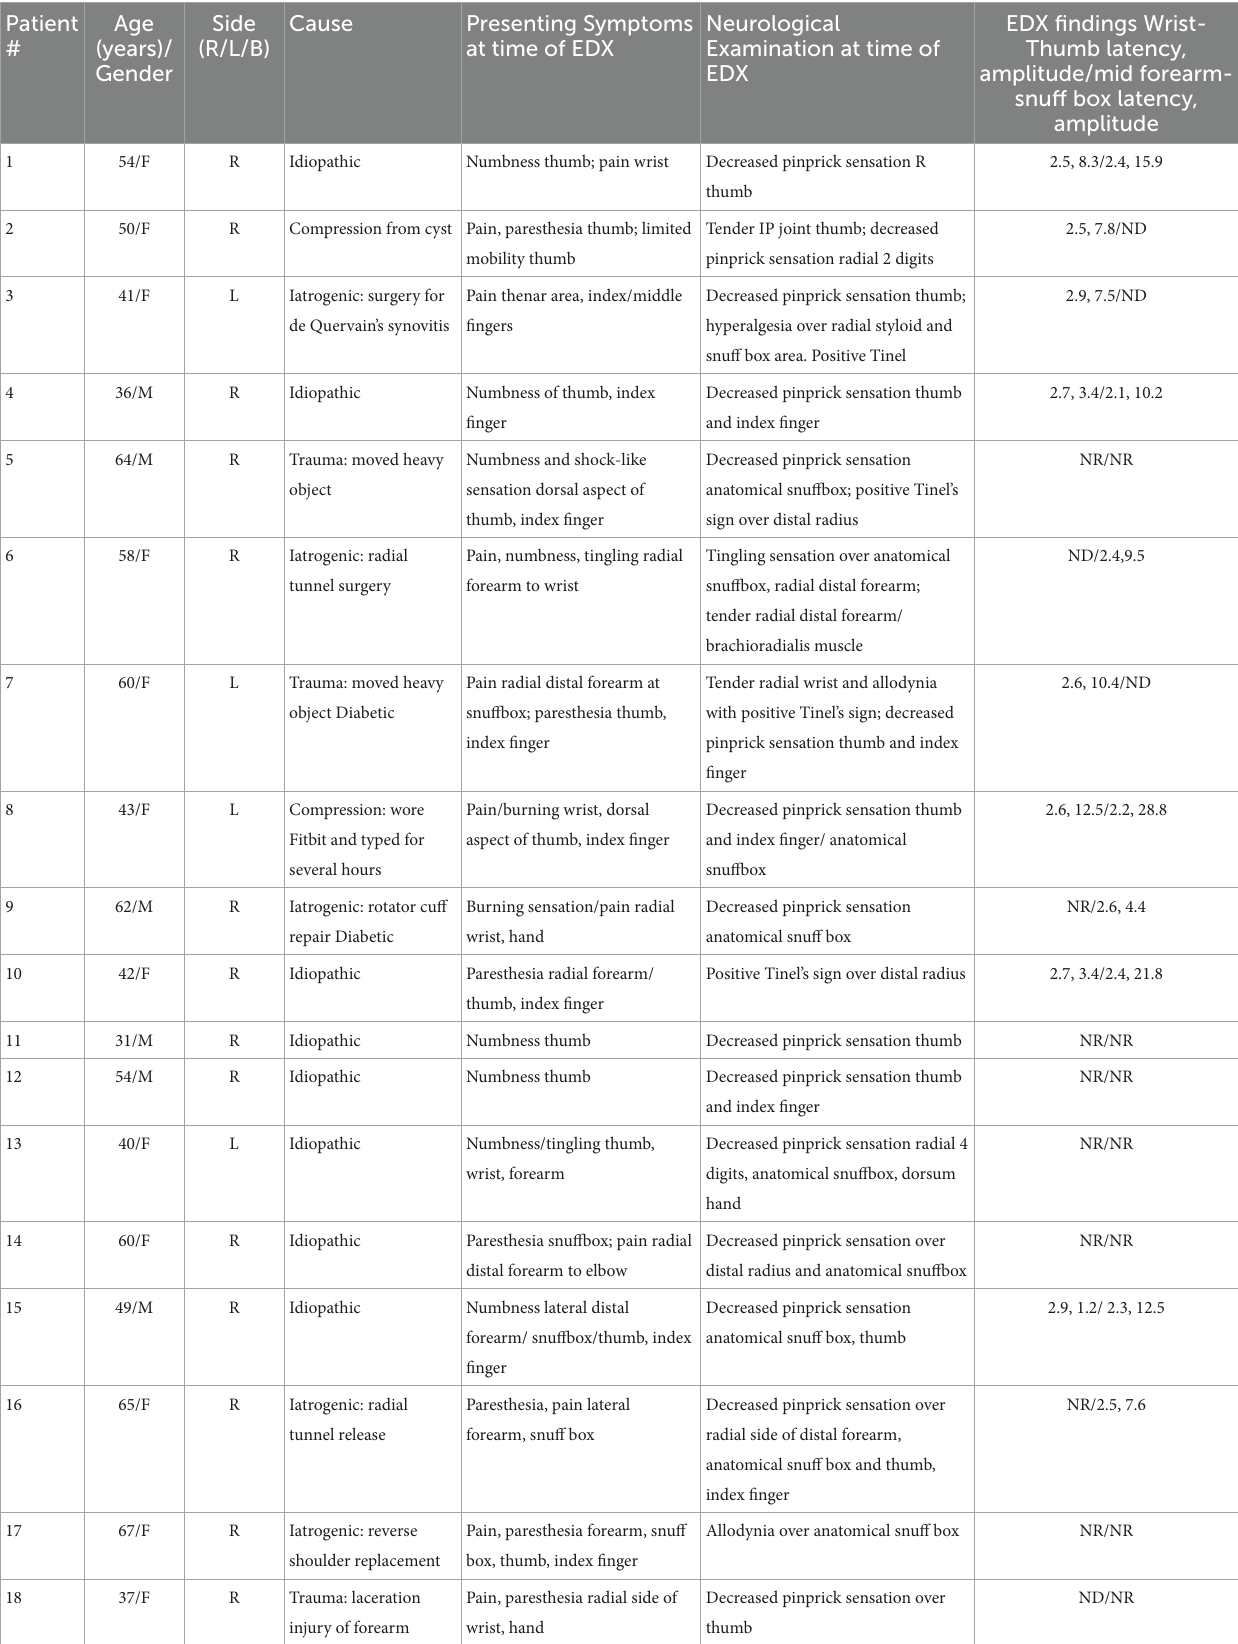
TABLE 1 Demographics, presenting symptoms, neurological examination, and electrodiagnostic studies of patients with superficial radial nerve neuropathy referred for electrodiagnostic studies at our facility. Patient